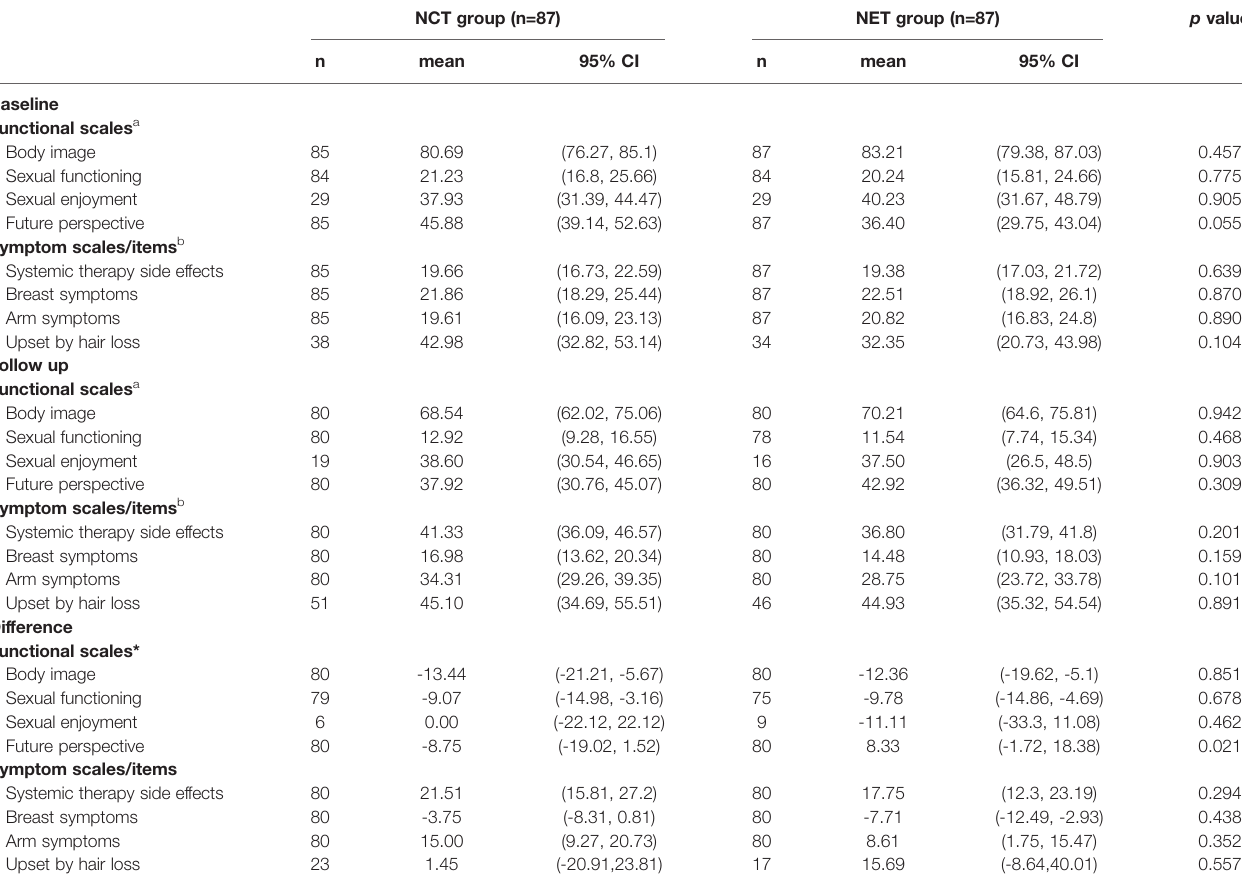
TABLE 2 | Baseline and follow-up EORTC QLQ-BR23